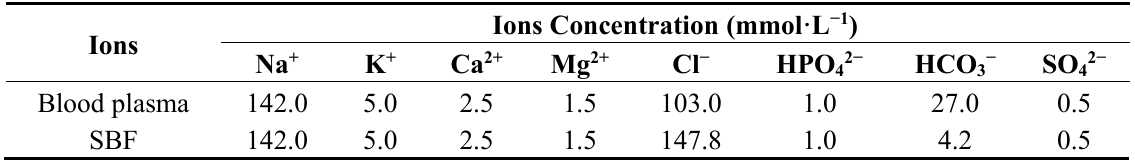
Table 2. The ions concentration of human blood plasma and SBF.